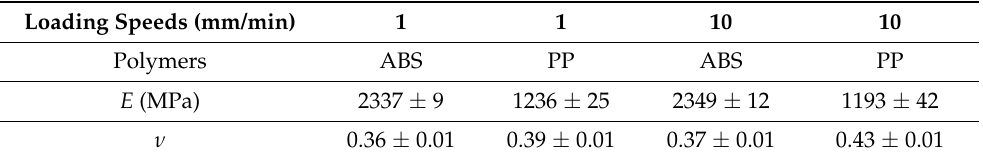
Table 1. Elastic properties of virgin polymers (ABS and PP) deduced from instrumented tensile tests at 1 and 10